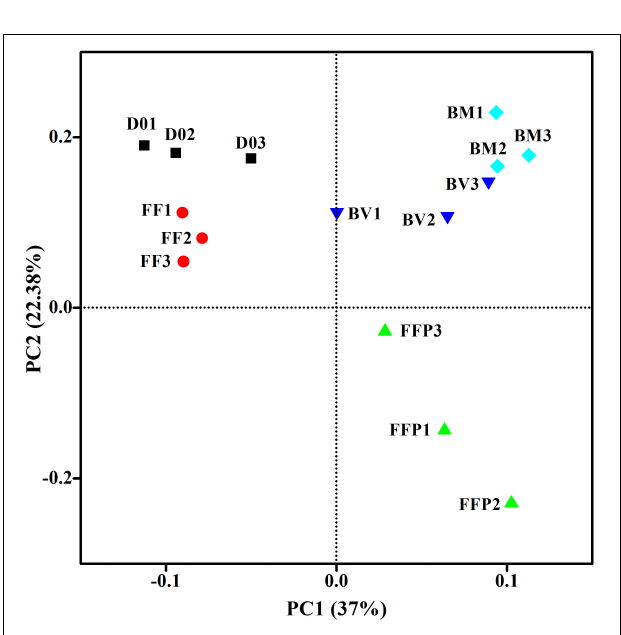
FIGURE 6 | Heat map of the relative abundance of the most abundant operational taxonomic units (OTUs) (the abundance > 2%) from initial soil samples and acetate-fed samples (D0: initial soil sample; FF: ferrihydrite-free cultures; FFP: ferrihydrite-free + P cultures; BM: biogenic-magnetite cultures; and BV: biogenic-vivianite